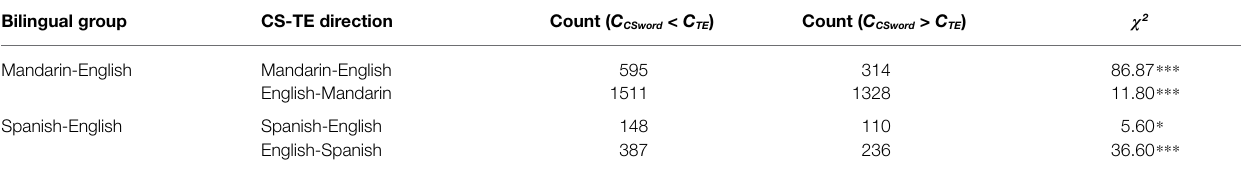
TABLE 4 | Statistical results of the sign tests for the clustering coefficient of words. Bilingual group CS-TE